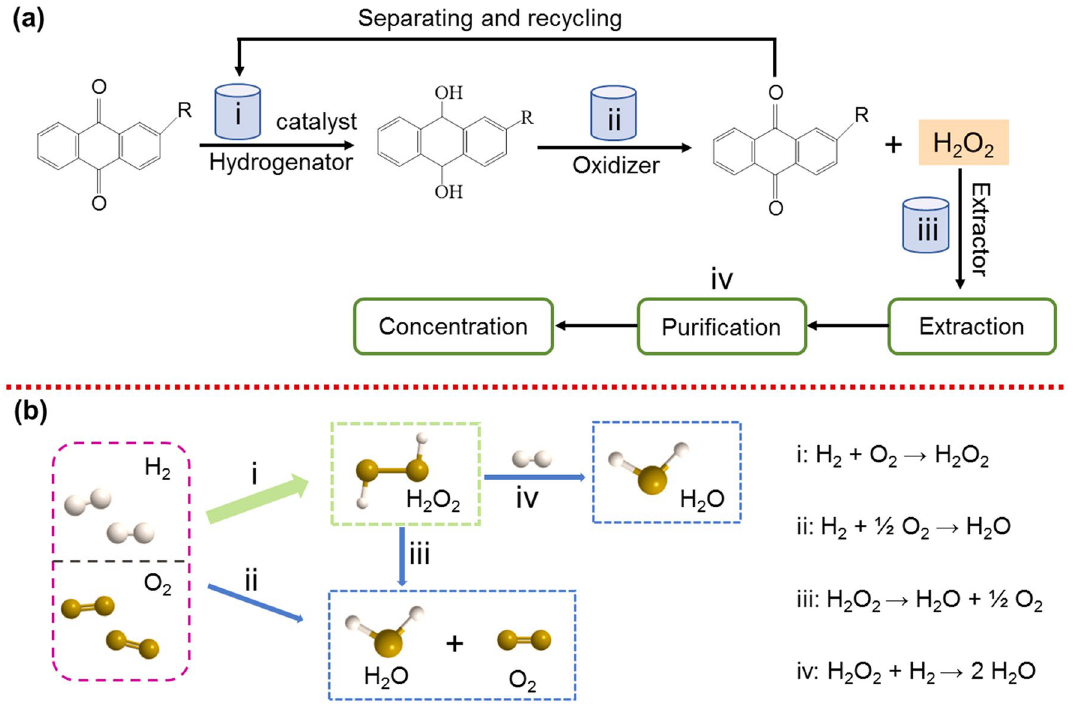
Fig. 1 Schematic illustration of a the anthraquinone (AQ) oxidation process and b the direct synthesis from H 2 and O